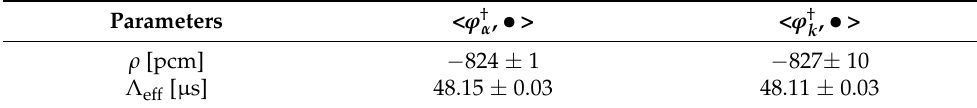
Table 22. Effective kinetics parameters for the H2 configuration including delayed contributions.